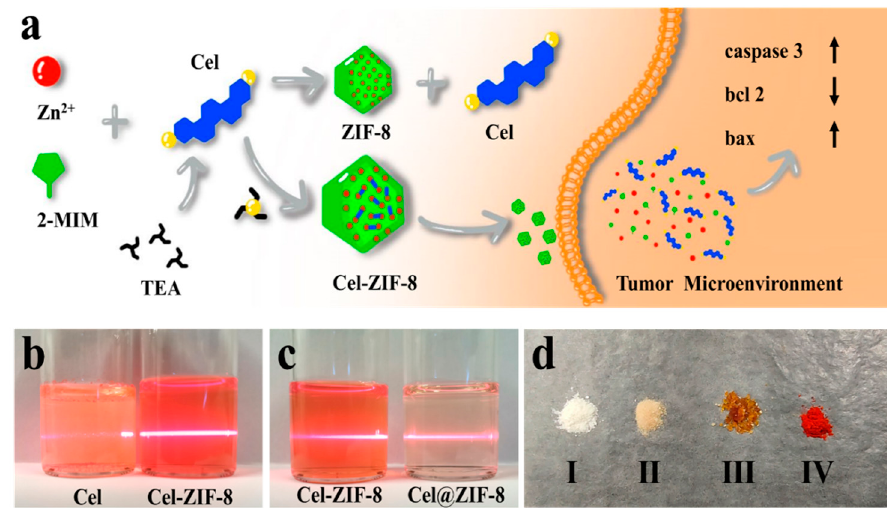
Scheme 1. Schematic illustration of the synthesis and characterization of Cel-ZIF-8 and